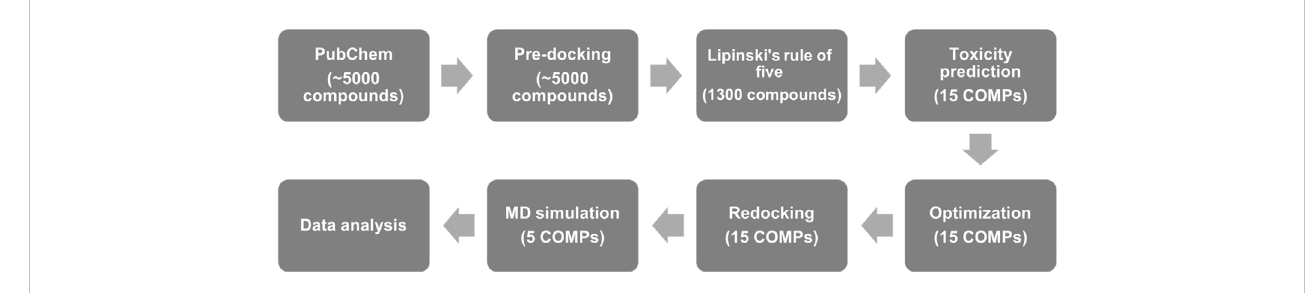
FIGURE 1 The fl ow chart of anti-prion screening based on pharmaceutical activity prediction, molecular docking, and MD